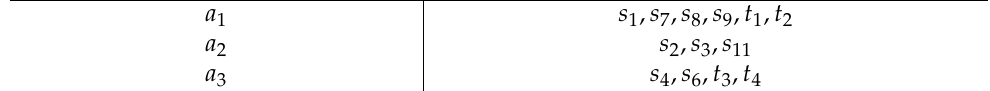
Table 4. Area construction with θ = 0.4.